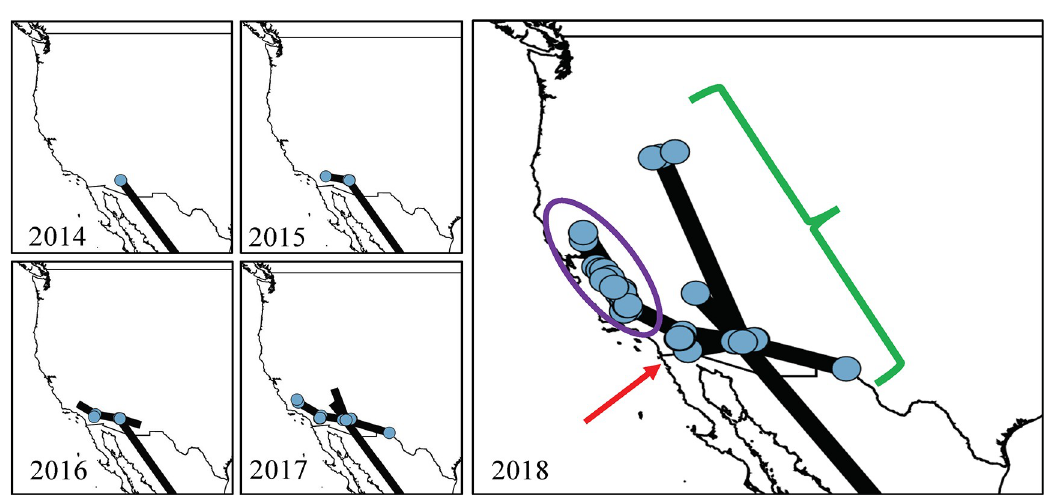
Fig 4. Geographic expansion of SLEV genotype III likely followed three routes throughout the Western US. Genomes and inferred ancestors are represented with blue circles. The inferred SLEV expansion is depicted for each year for 2014–2017 and a composite is shown for 2014–2018. Route one, shown by a red arrow, consists of SLEV expansion from AZ into Southern CA. Route two, circled in purple, involves SLEV transported from AZ into the Central Valley of CA. Route three, indicated with a green bracket, represents SLEV movement from AZ to all locations east of the Sierra Nevada